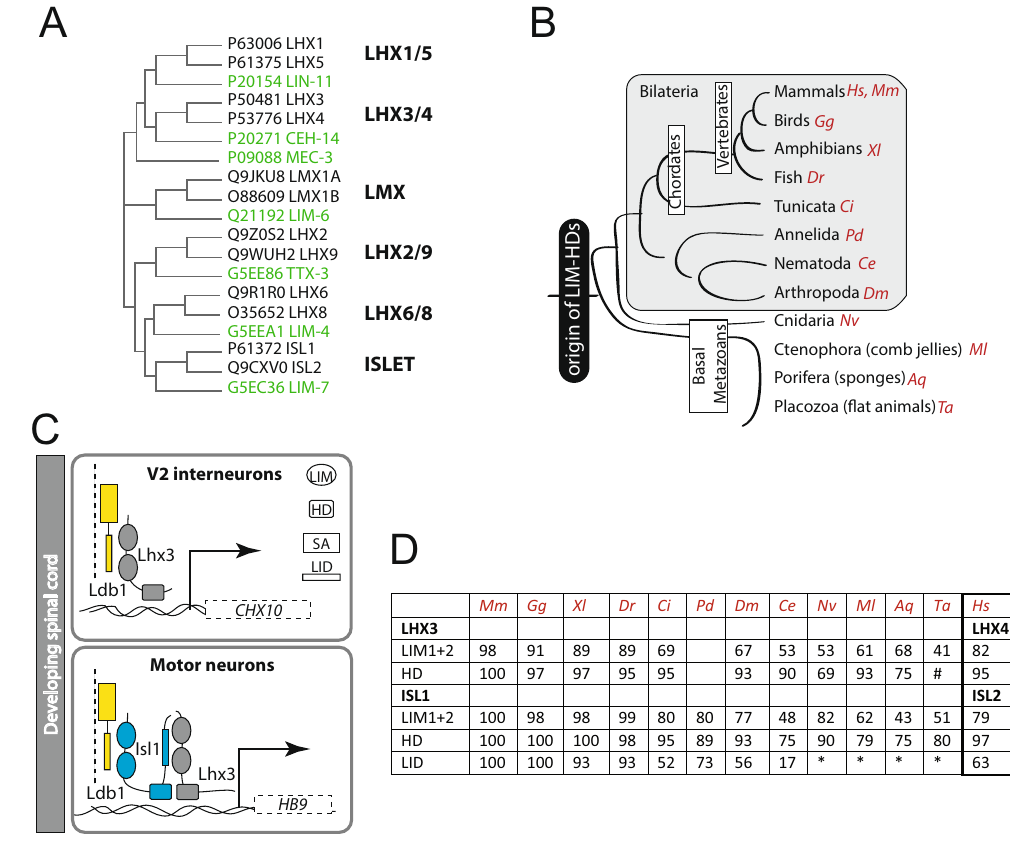
Figure 1. Islet- and LHX3-family LIM-HD proteins and interactors. ( A ) Simple phylogenetic tree diagram of LIM-HD proteins from mouse (black) and C. elegans (green) illustrating the LIM-HD families; Uniprot accession codes are provided. Branches and relationships are derived from analysis of these proteins using CLUSTAL OMEGA and CLUSTAL PHYLOGENY. Distances are not to scale. ( B ) Schematic of evolutionary relationships in metazoans. Hs – Homo sapiens; Ms – Mus musculus; Gg – Gallus gallus, Xl – Xenopus laevis, Dr – Danio rerio, Ci – Ciona intestinalis, Pd - Platynereis dumerilii , Ce -Caenorhabditis elegans, Dm – Drosophila melanogasta, Nv - Nematostella vectensis, Ml - Mnemiopsis leidyi, Aq- Amphimedon queenslandica, Ta - Trichoplax adhaerens . The branchpoints between some basal metazoans are controversial 70, 71 and not indicated here. ( C ) Distinct transcriptional complexes drive different transcription programs in adjacent cell types in the developing ventral spinal cord in vertebrates. ( D ) Sequence identity (% compared to Hs proteins) between domains in metazoan LHX3 and ISL1 proteins. No domain identified ( * ), substantially truncated domain identified ( # ). No Pd LHX3 gene was